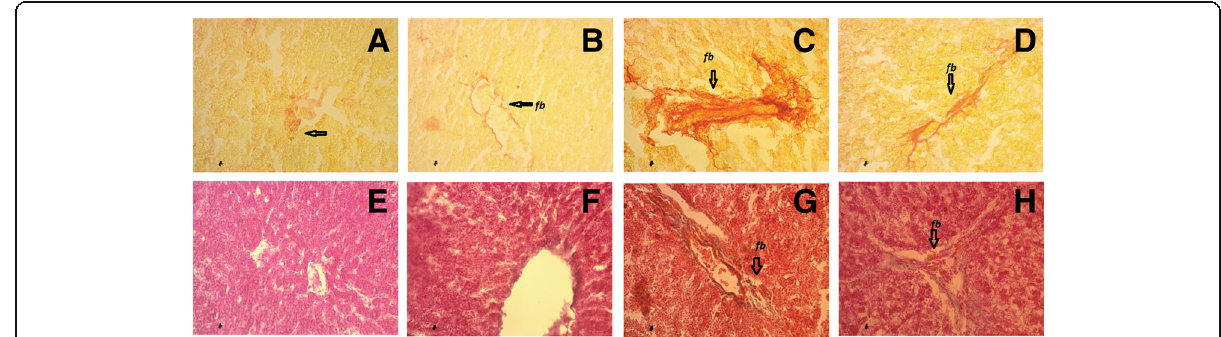
Fig. 5 Effect of Syzygium cumini seed powder supplementation on hepatic fibrosis in high fat diet fed obese rats. a , e Control; b , f Control + Syzygium cumini seed; c , g HCHF; d , h HCHF+ Syzygium cumini seed. Magnification 40 X